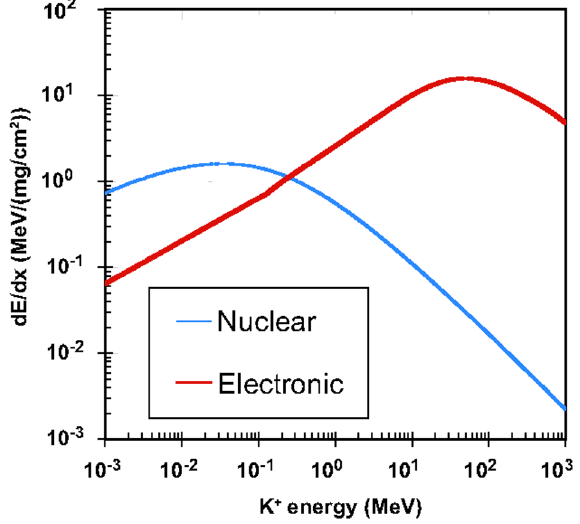
FIG. 17. (Color) The ion energy loss due to nuclear large-angle scattering (blue line) and to interaction with electrons (thick red line) is shown versus energy for K (cid:6) ions incident on stainless